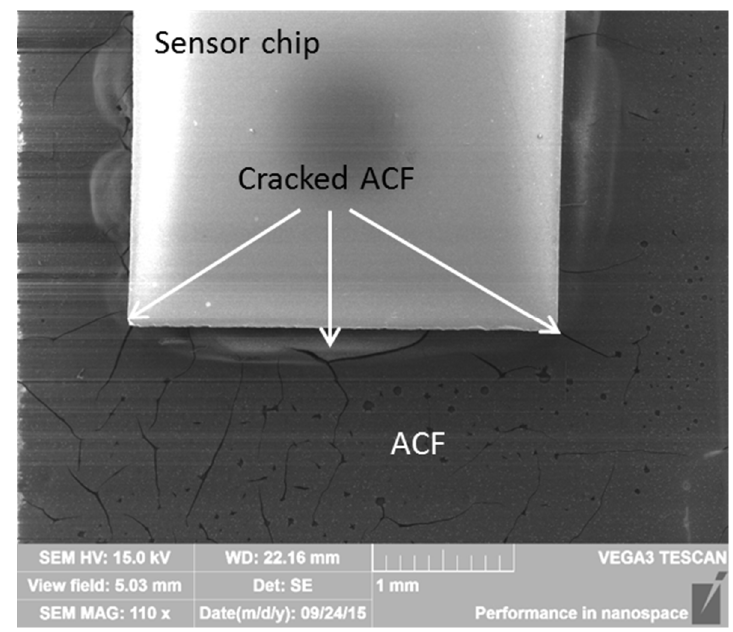
Figure 18. SEM image showing the cracked ACF surface of Rogers PCB sample aged for 480 h at 240 °C.